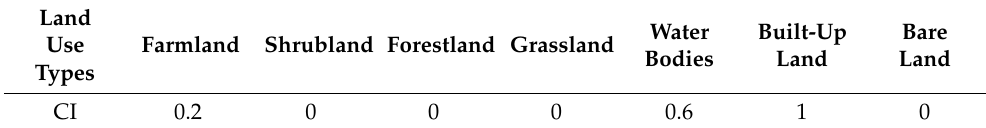
Table 3. Construction land equivalent conversion coefficients (CI) of various land use types in the